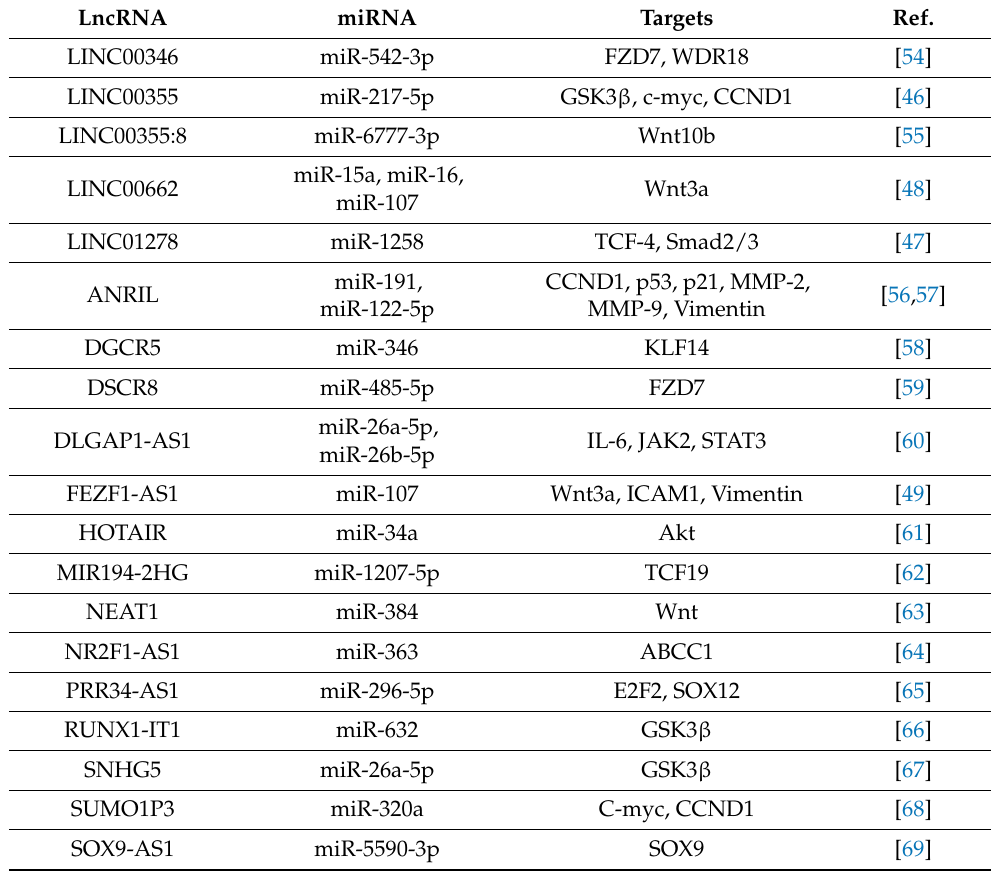
Table 1. The list of lncRNAs and their related miRNAs in regulation of Wnt/ β -catenin signaling in HCC.